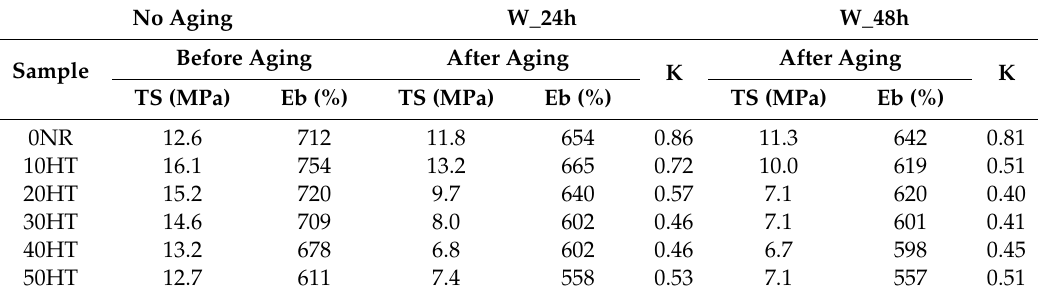
Table 6. The changes in mechanical properties before and after simulated weather aging processes and aging factor (K) for biocomposites. Standard deviations did not exceed: TS ± 0.4 MPa, Eb ± 8%, K ±